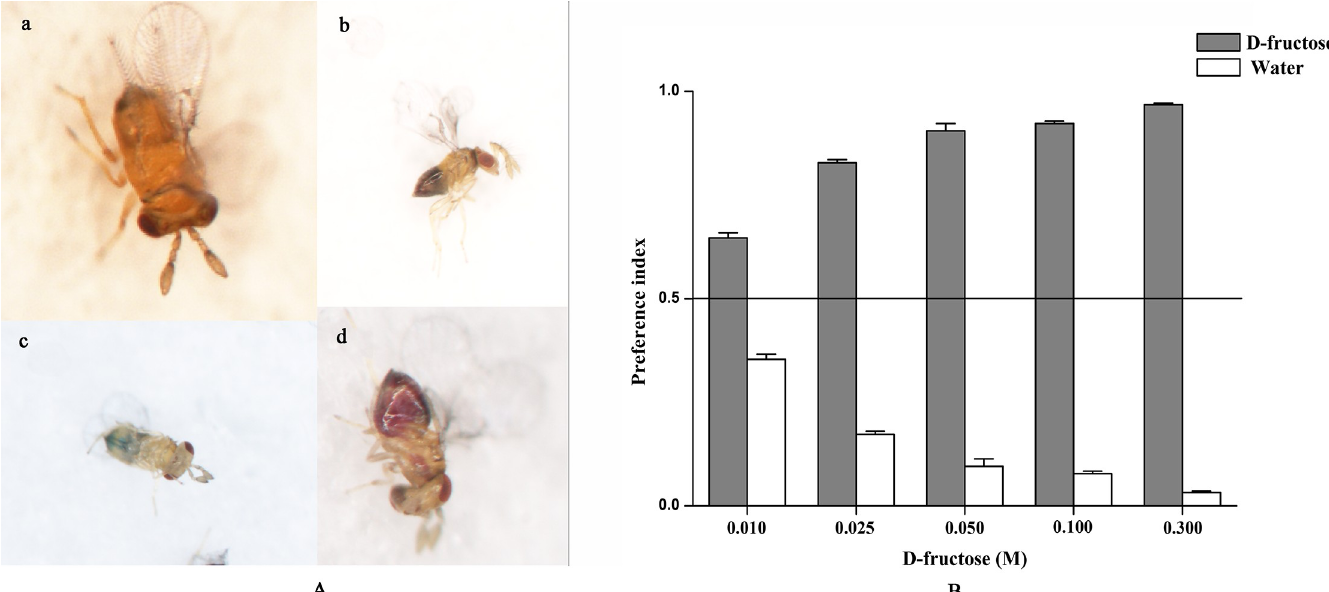
Fig 1. Behavioral preference to D-fructose of T . chilonis . A: a, T . chilonis fed nothing; b, T . chilonis fed both fructose and water; c, T . chilonis fed water; d, T . chilonis fed sugar. B: Relative sensitivity of D-fructose was determined by two-choice preference tests. PI values for D-fructose are shown at the following concentrations: 0.010, 0.025, 0.050, 0.100 and 0.300 M every concentration was tested with 50–60 adults. Error bars indicate SEMs from the analysis of three replications (P < 0.05).